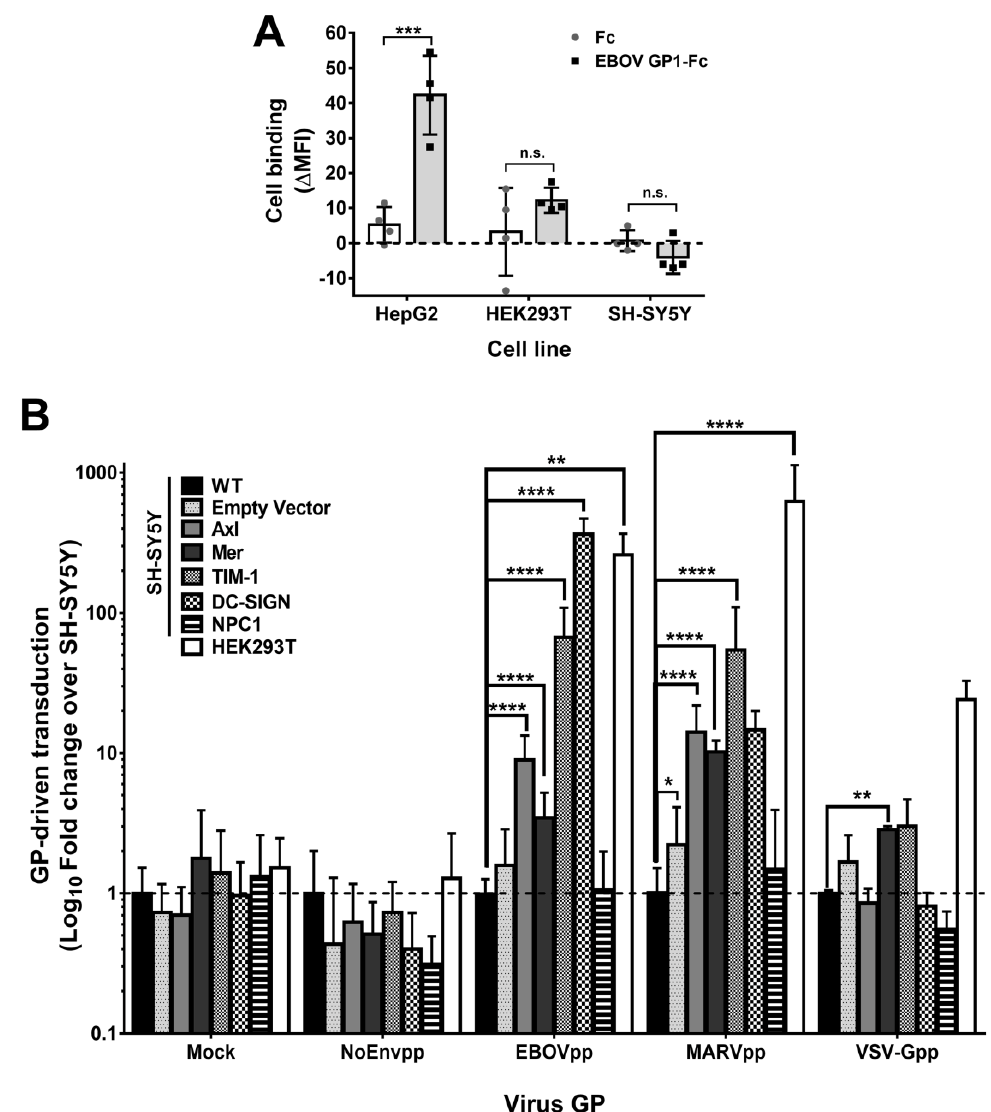
Figure 8. Impaired filovirus attachment on SH-SY5Y cells can be overcome by surface factor overexpression. ( A ) Binding of EBOV GP-Fc fusion protein to cell surface. EBOV-GP1 and human Fc (100 nM) were incubated for 1.5 h with the indicated cell lines and detected with a secondary ab against the human Fc fragment. MFI signal was recorded for Fc or EBOV GP1-Fc and subtracted from secondary ab MFI. Bars represent mean of two biological replicates performed in duplicate ( n = 4) and symbols represent each individual value. Error bars represent the SD. ( B ) Overexpression of several cell surface factors and their role in filoviral GP-dependent entry. Susceptible HEK293T, resistant SH-SY5Y WT or SH-SY5Y cells genetically engineered to individually express different entry host factors were transduced with NoEnv, EBOV, MARV, and VSV-G luciferase-encoding pseudoparticles. Mock infection was performed to control background signal. Enhanced susceptibility to filovirus infection was calculated as the fold change difference over SH-SY5Y WT cells by dividing the RLU values of 100 µl lysed cells of each engineered cell line and HEK293T cells with the SH-SY5Y WT RLU values. Fold change differences between SH-SY5Y WT and HEK293T or engineered SH-SY5Y cell lines were used for statistical analysis. Graph is the representation of 3 independent transductions done in triplicate ( n = 9). Error bars depicts SD. For the analysis of significance in all 3 graphs a multiple t test with a Holm–Sidak multiple comparison correction method was conducted. P -value significance is shown as: n.s. P > 0.05; * P ≤ 0.05; ** P ≤ 0.01; *** P ≤ 0.001; **** P ≤ 0.0001.